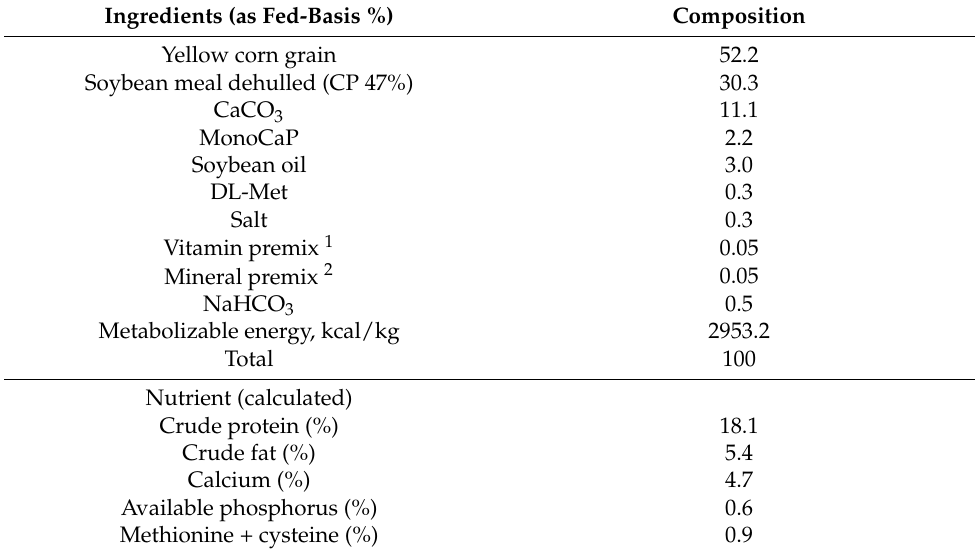
Table 1. Diet composition and calculated nutrition levels. Ingredients (as Fed-Basis